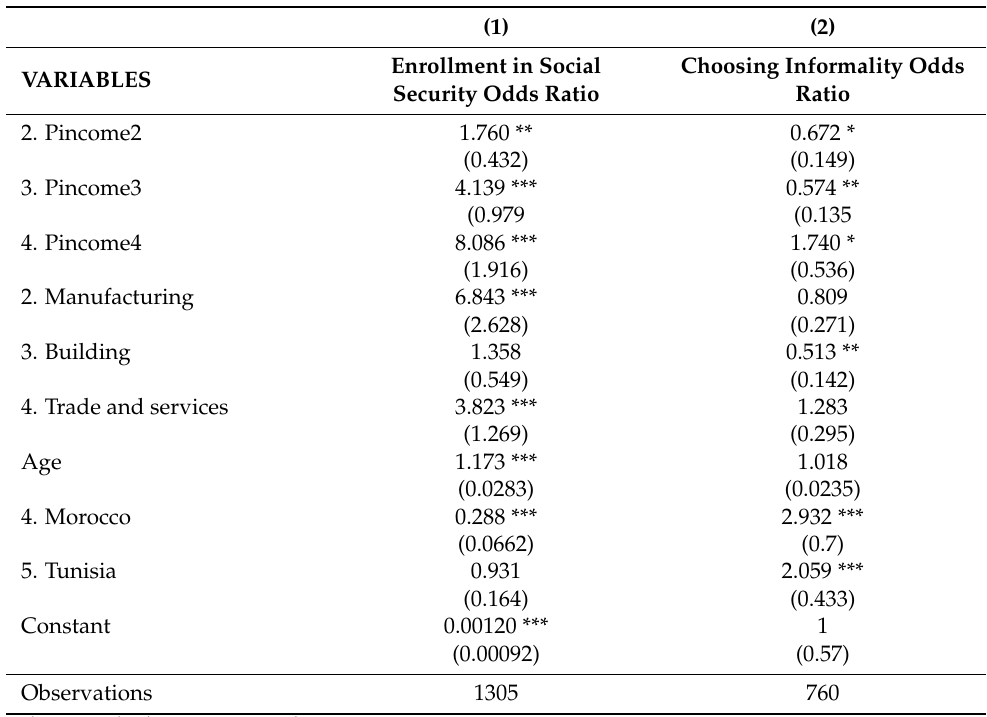
Table 3. Logit models. Dependent variables: enrollment in social security and choosing informality. Source: Sahwa dataset using